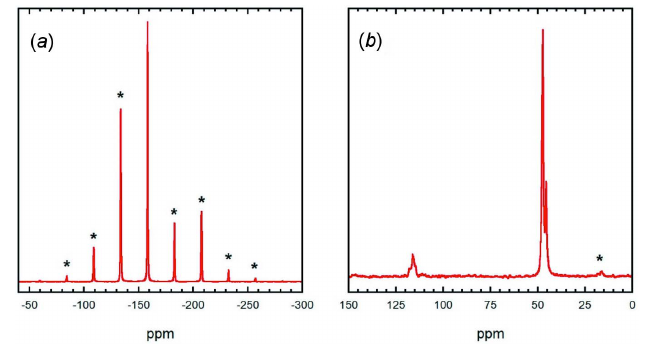
Figure 7 ( a ) 31 P MAS NMR spectrum for 2 obtained using a spinning speed of 5 kHz. The sideband pattern is corresponds to a chemical shift anisotropy (csa) with isotropic shift of (cid:4) 158 p.p.m., d aniso = (cid:4) 59.3 ppm, and h = 0.00; ( b ) 13 C MAS NMR spectrum for 2 obtained using a spinning speed of 12.5 kHz. Note that in both spectra, spinning sidebands are marked with asterisks ( *